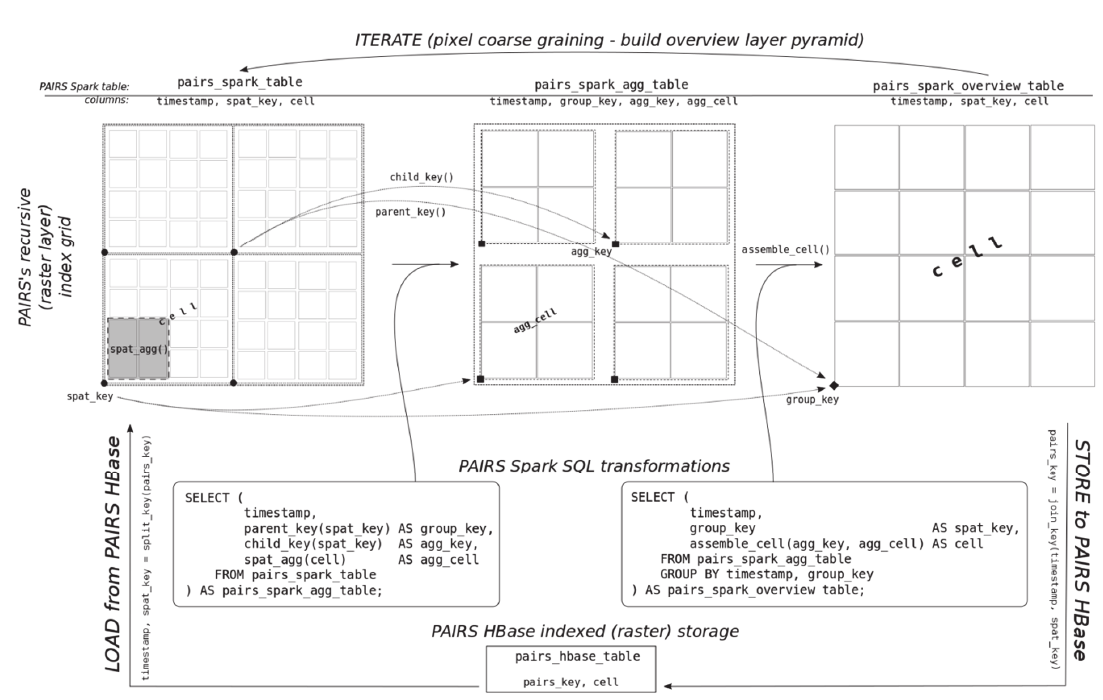
Figure 4: Cartoon to illustrate how Apache Spark DataFrames can be used in IBM PAIRS in order to coarse-grain raster